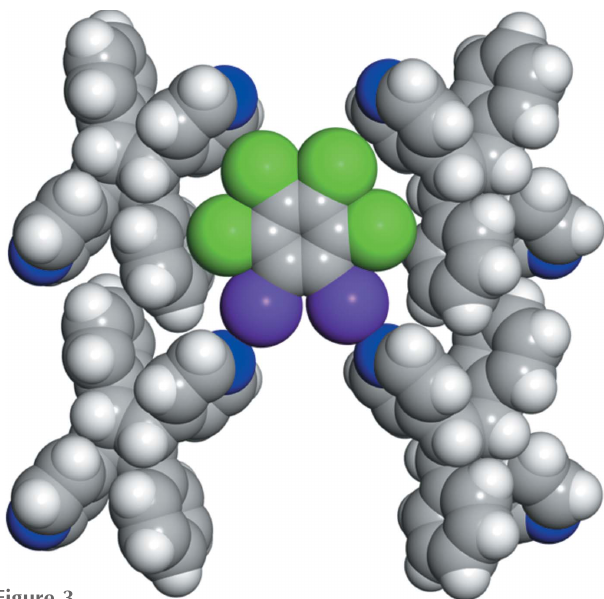
Figure 3 Space-filling model of ( 1,2-C 6 I 2 Cl 4 ) (cid:2) ( ht -PP ) illustrating a closer view of the various Cl (cid:2)(cid:2)(cid:2) (cid:2)